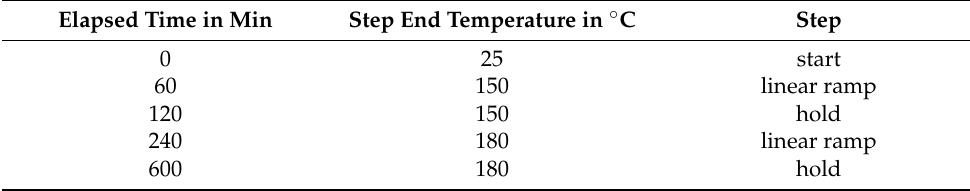
Table 2. Post-cure cycle for molded plates.